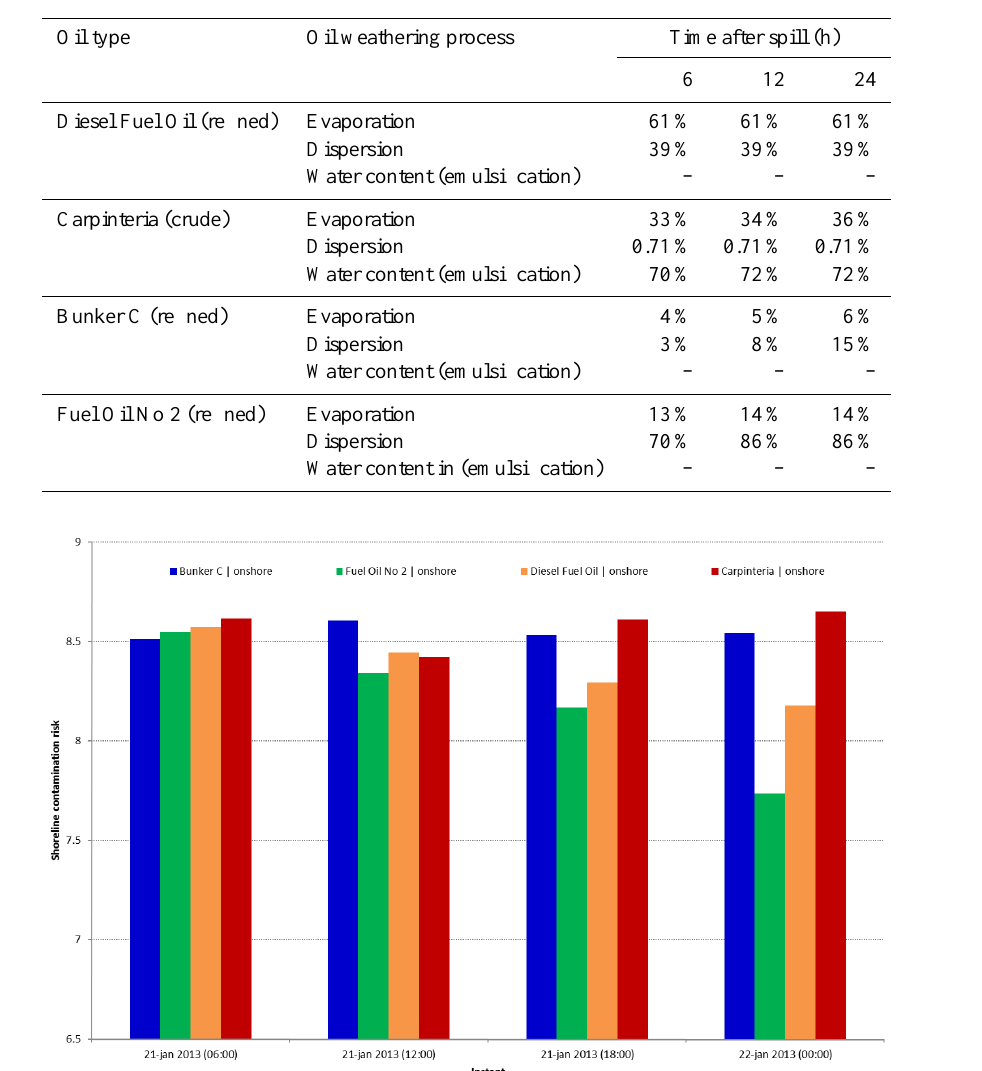
Table 3. Evolution in time of approximated oil mass lost and water content in oil (as percentage of mass) as a result of the main weathering processes, in four oil types, under regular metocean conditions in the pilot area (wind: 10ms − 1 ; significant wave height: 2.5m; water temperature: 15 ◦ C).